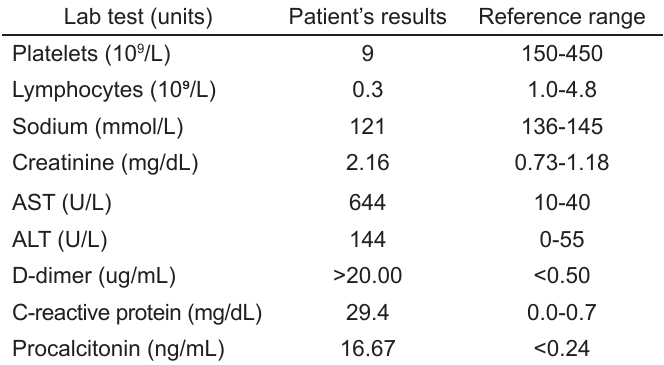
Table. Patient’s significant laboratory values with site’s reference